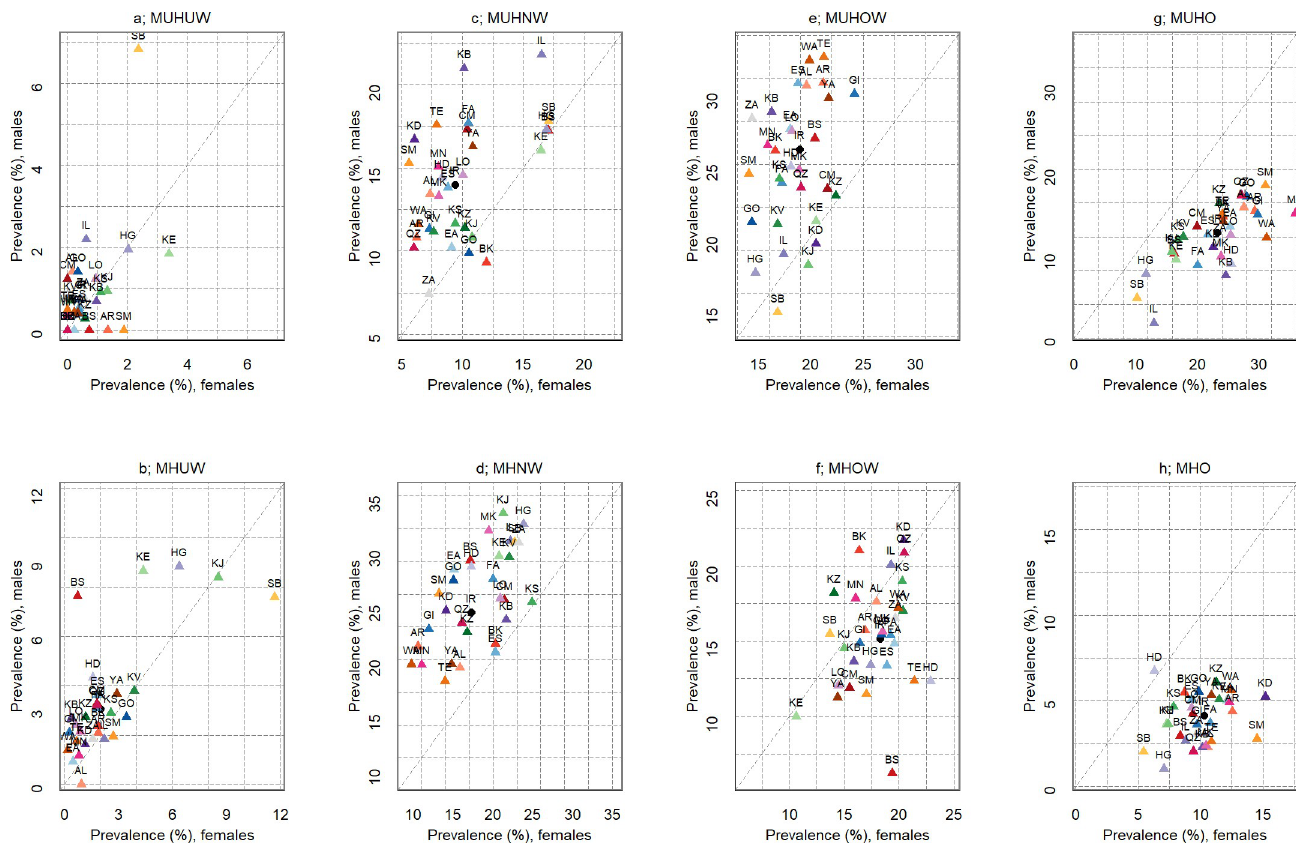
Fig 3. Sub-national prevalence of metabolic phenotypes for each BMI category by sex. (a) MUHUW: metabolically unhealthy underweight, (b) MHUW: metabolically healthy underweight, (c) MUHNW: metabolically unhealthy normal weight, (d) MHNW: metabolically healthy normal weight, (e) MUHOW: metabolically unhealthy overweight, (f) MHOW: metabolically healthy overweight, (g) MUHO: metabolically unhealthy obese, (h) MHO: metabolically healthy obese.